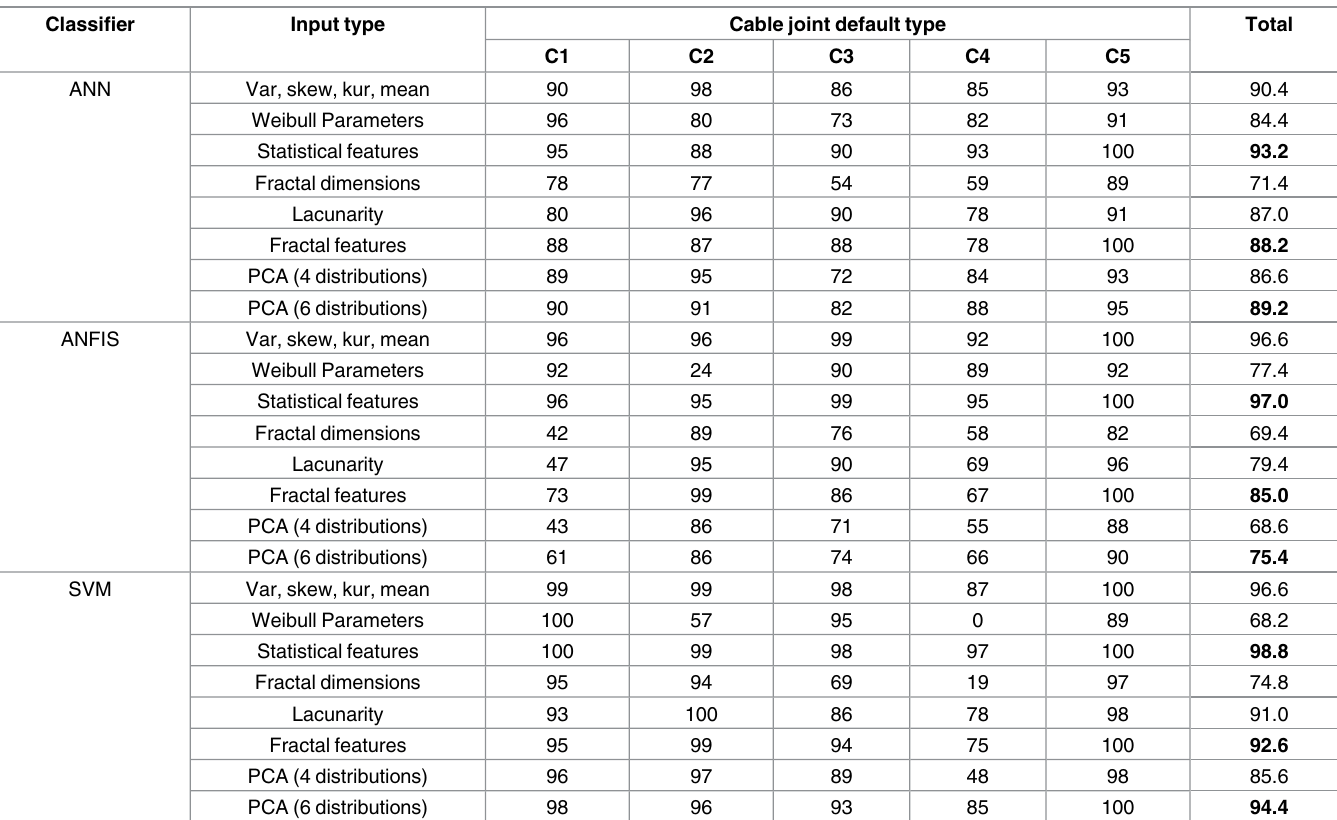
Table 5. Classification accuracyresults using noise-free PD